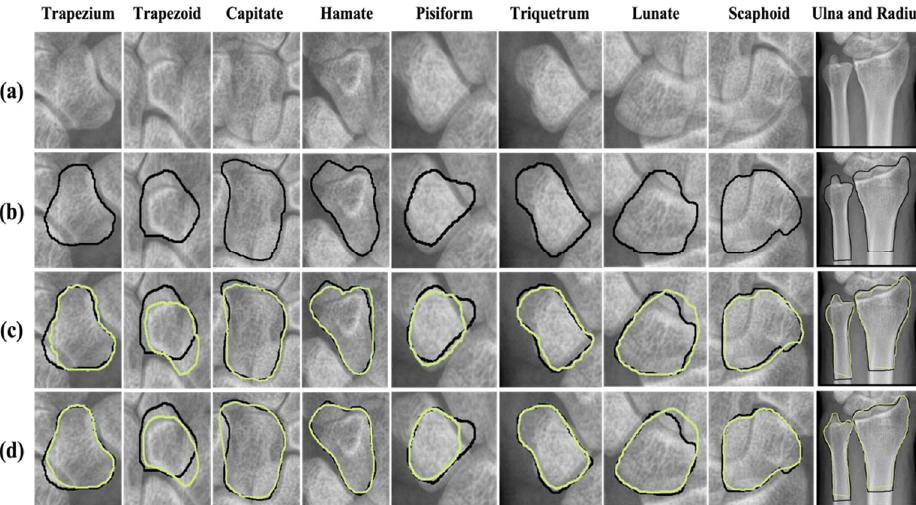
Figure 3. Visualization of Fine Mask R-CNN and Mask R-CNN network for the segmentation of ten wrist bones. ( a ) Original image of each wrist bone on the radiograph, ( b ) Delineation of segmented bone by physicians manually, ( c ) Delineation of segmented bone by Mask R-CNN, ( d ) Delineation of segmented bone by Fine Mask R-CNN with an extended mask head. Black lines indicate the ground truth masking segmented by physicians and yellow lines indicate the predicted masking segmented by CNN. CNN; convolutional neural networks.